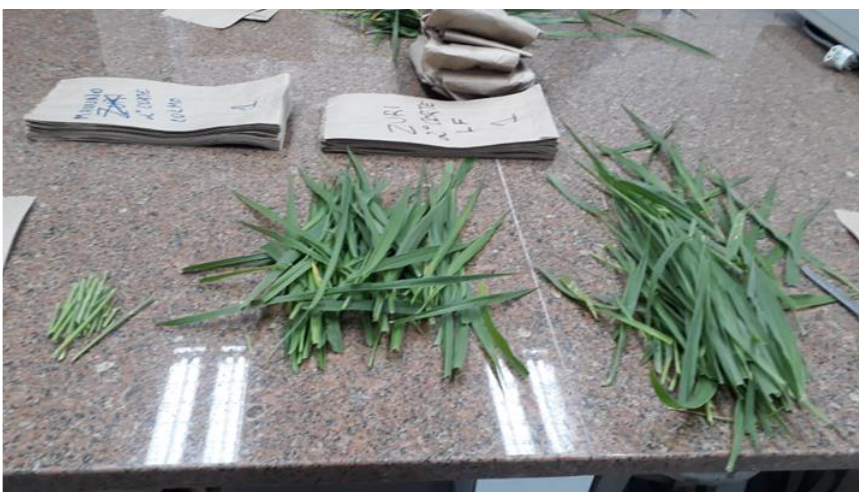
Figure 3. Identification of stem + sheath.